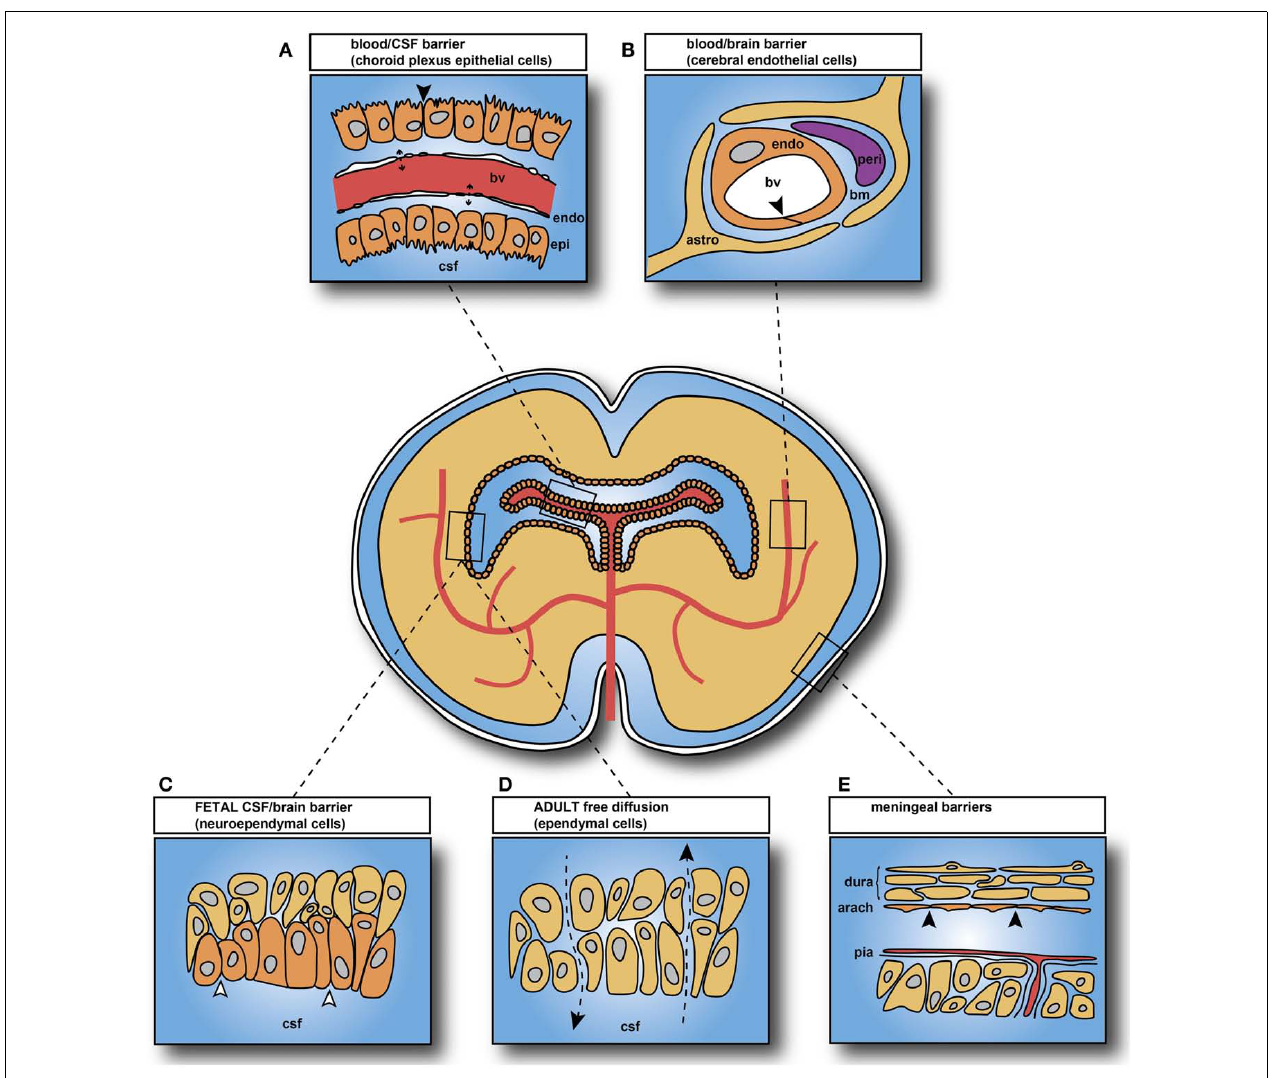
pial blood vessels. In embryos: additional membrane specializations at the CSF–pial interface (Møllgård et al., 1987). Abbreviations: bv, blood vessel; endo, endothelial cell; epi, epithelial cell; bm, basement membrane; peri, pericyte; astro, astrocyte (astrocytes not yet differentiated in brain when blood vessels first appear; thus they cannot contribute to tight junction formation in early brain development). Black arrowheads: sites of tight junctions; open arrowheads: sites of strap junctions. Redrawn from Saunders et al.